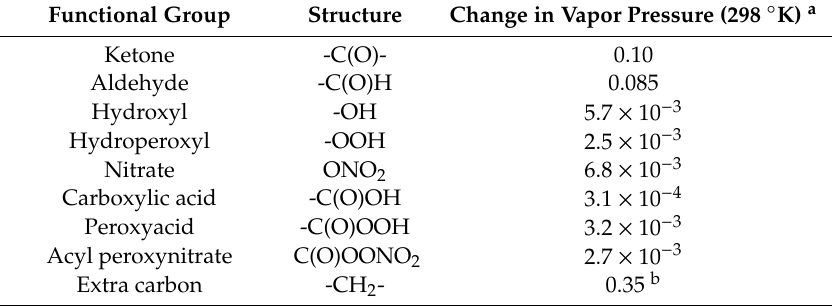
Table 3. Vapor pressure change of an organic compound with addition of a common functional group, based on group contributions calculated by Pankow and Asher [192]. (Reproduced from Kroll and Seinfeld [40] with permission from Elsevier).